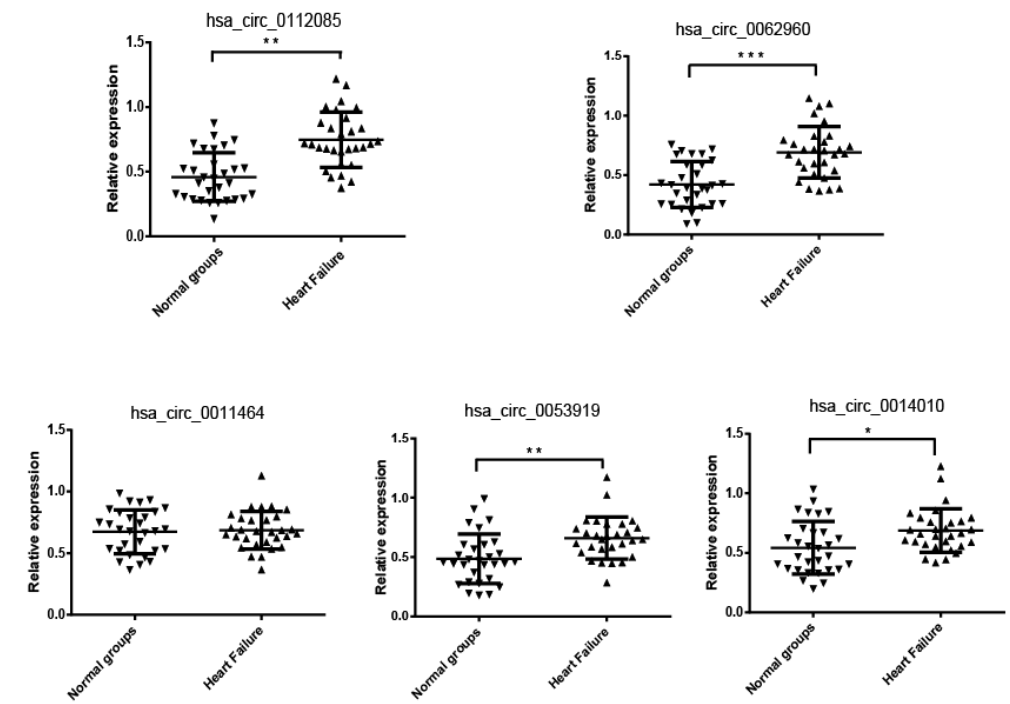
Figure 2. qRT-PCR validation for the expression level of hsa_circ_0112085, hsa_circ_0062960, hsa_circ_0011464, hsa_circ_0053919, and hsa_circ_0014010. The cohort included 30 patients with HF